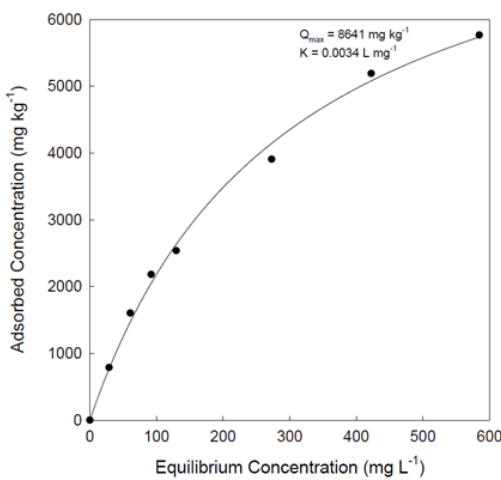
Figure 1. Langmuir adsorption isotherm of 0 to 640 mg L − 1 salicylate onto goethite at pH 5. The Q max and K values are the statistical fit values for the Langmuir parameters.